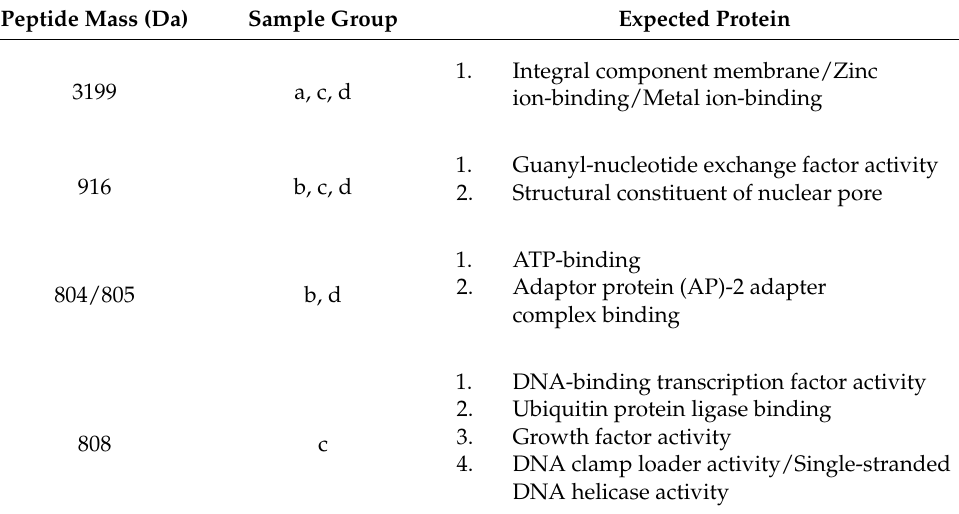
Table 3. Identification of mass spectral peak of peptides in the study